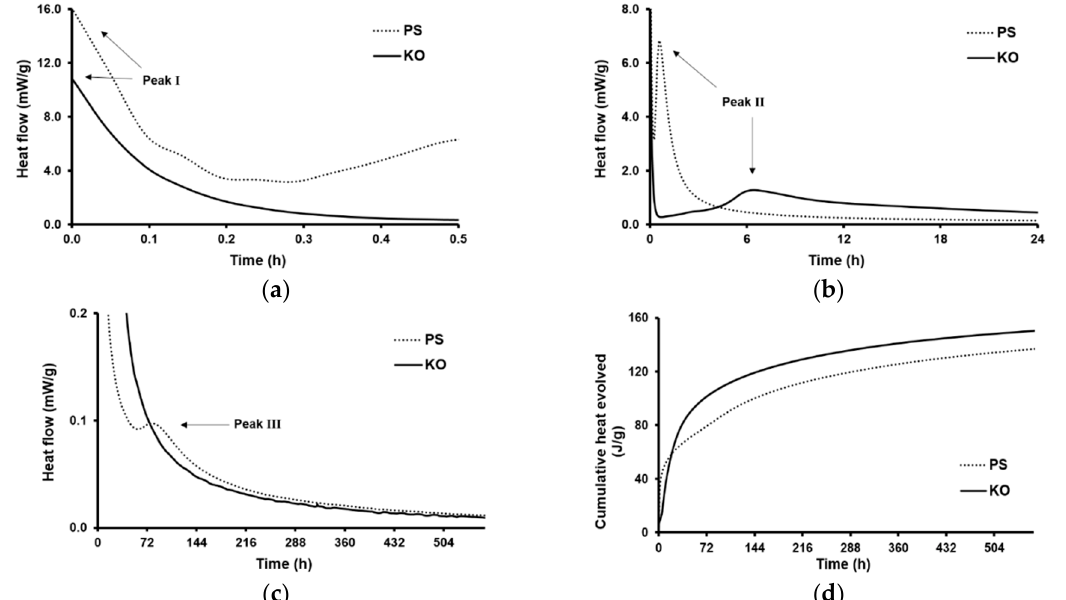
Figure 3. Isothermal calorimetry curves of alkali activated pastes. Heat evolution rate during the initial: ( a ) 30 min and ( b ) 24 h period while ( c ) shows a close-up of a secondary heat peak detected on PS pastes (Peak III). The cumulative heat released by PS and KO pastes is shown in ( d ).